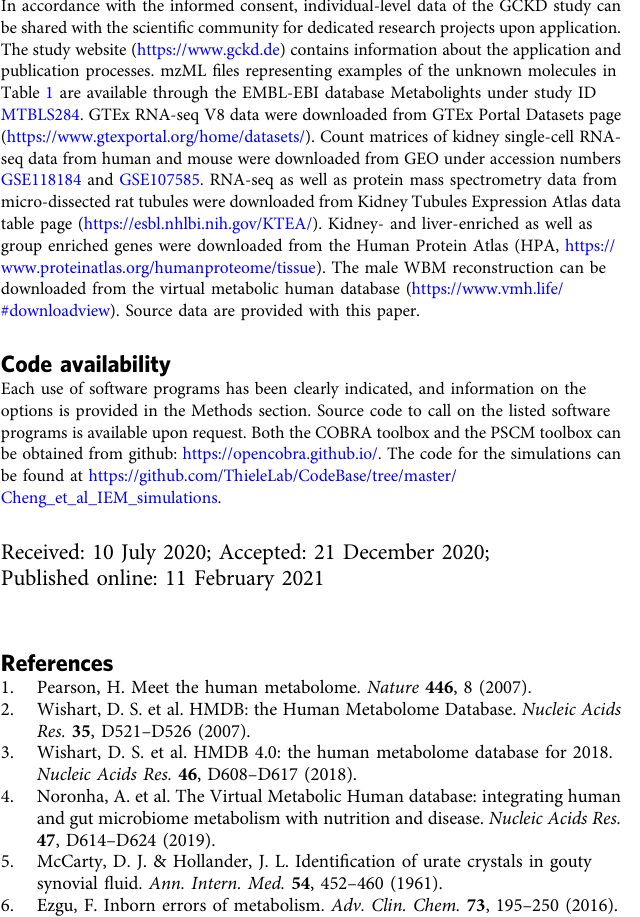
table page (https://esbl.nhlbi.nih.gov/KTEA/). Kidney- and liver-enriched as well as group enriched genes were downloaded from the Human Protein Atlas (HPA,